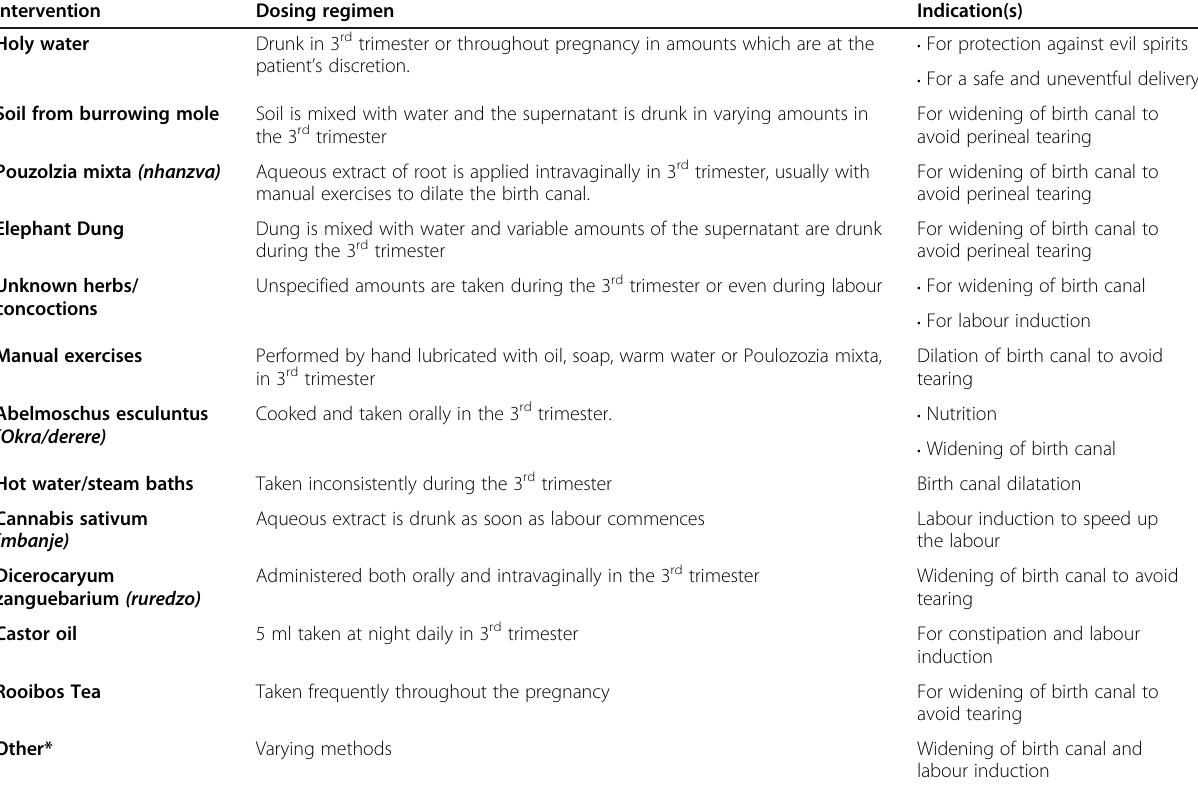
Table 2 Patterns of prenatal use of TM within the study